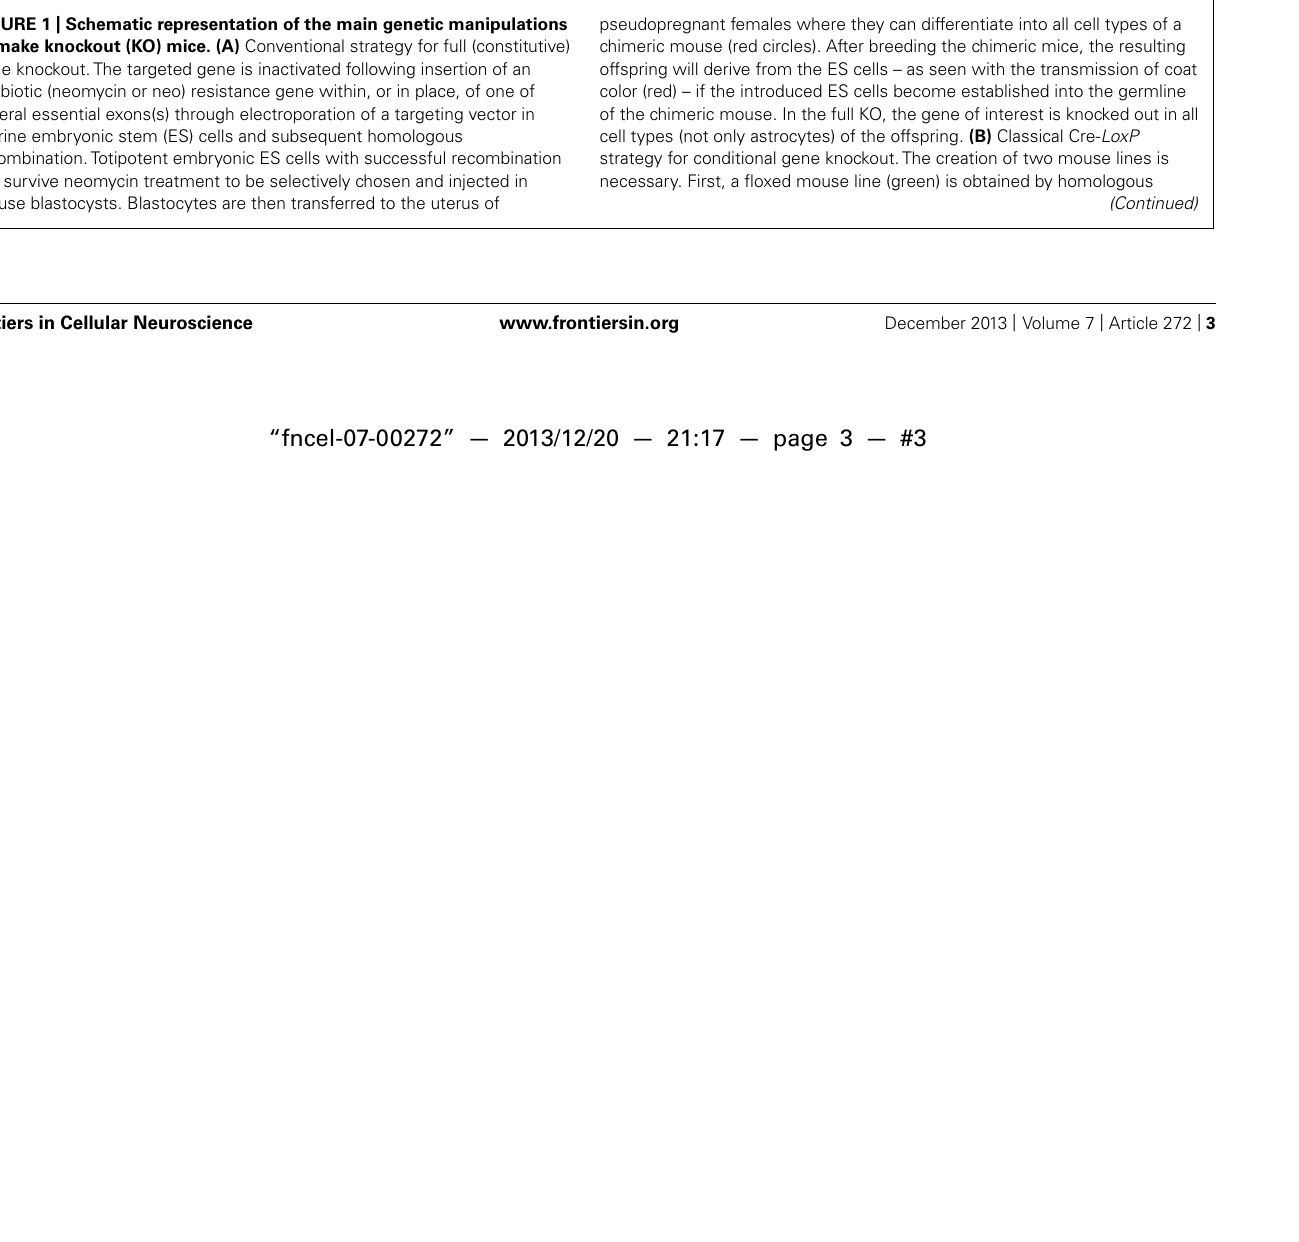
FIGURE 1 | Schematic representation of the main genetic manipulations to make knockout (KO) mice. (A) Conventional strategy for full (constitutive) gene knockout.The targeted gene is inactivated following insertion of an antibiotic (neomycin or neo) resistance gene within, or in place, of one of several essential exons(s) through electroporation of a targeting vector in murine embryonic stem (ES) cells and subsequent homologous recombination.Totipotent embryonic ES cells with successful recombination will survive neomycin treatment to be selectively chosen and injected in mouse blastocysts. Blastocytes are then transferred to the uterus of